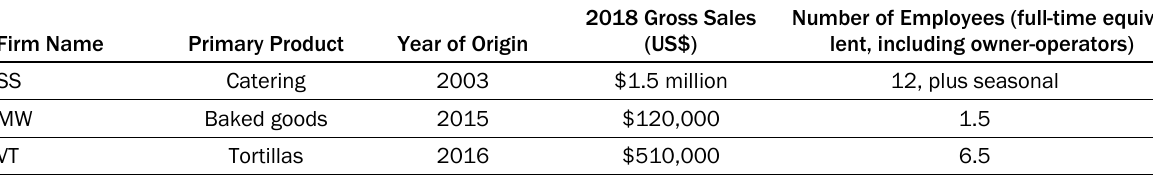
Table 1. Description of Sample